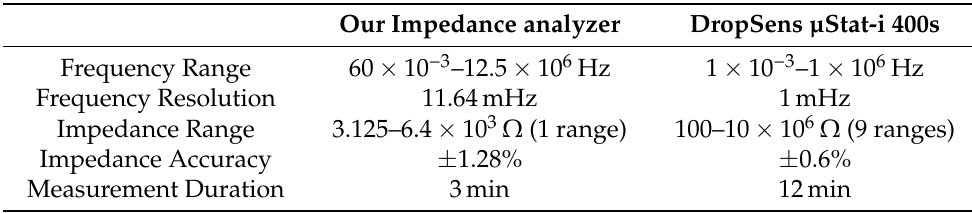
Table 3. Comparison of some impedance spectroscopy performance metrics.